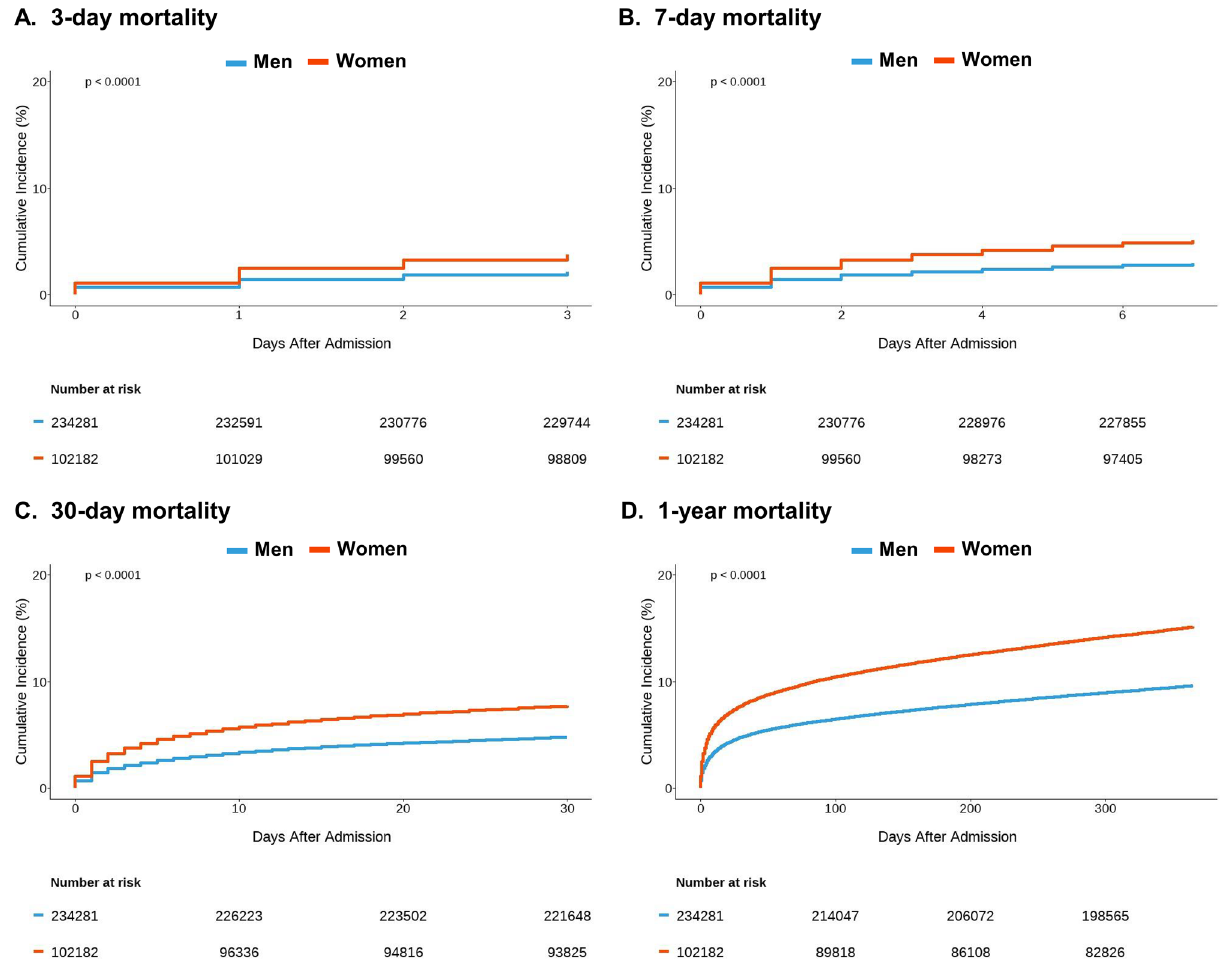
Figure 4. Gender differences in clinical outcomes. Kaplan–Meier curves of unadjusted 3-day ( A ), 7-day ( B ), 30-day ( C ), and 1-year ( D )